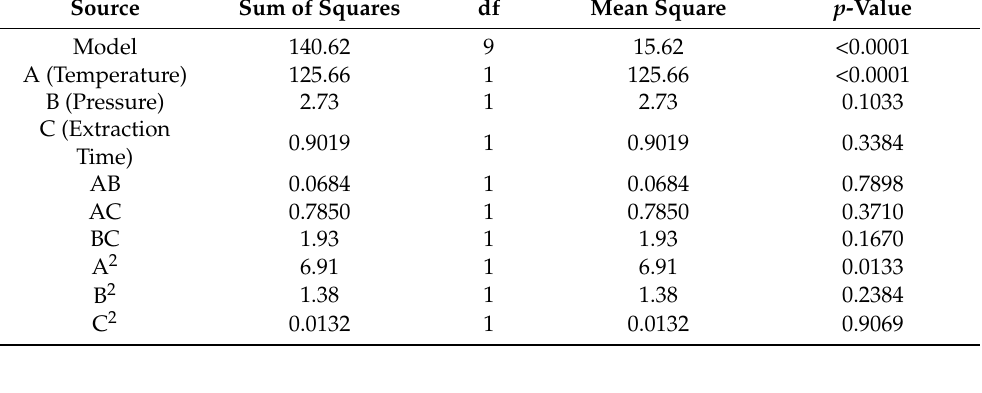
Table 3. The analysis of variance (ANOVA) table for the response surface quadratic model of the % yield of polysaccharides.